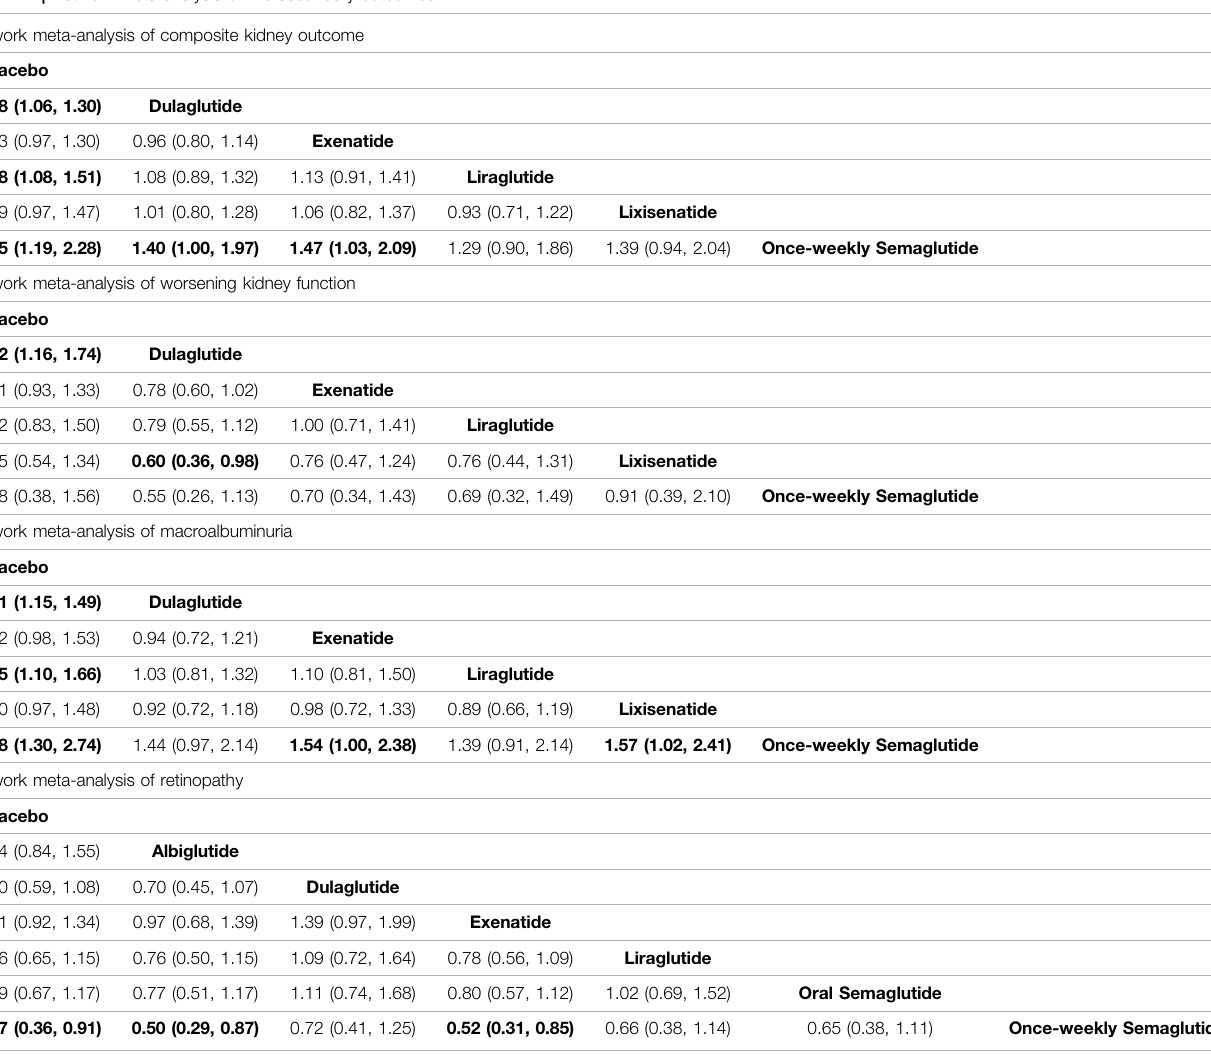
TABLE 4 | Network meta-analysis of fi ve secondary outcomes. Network meta-analysis of composite kidney outcome